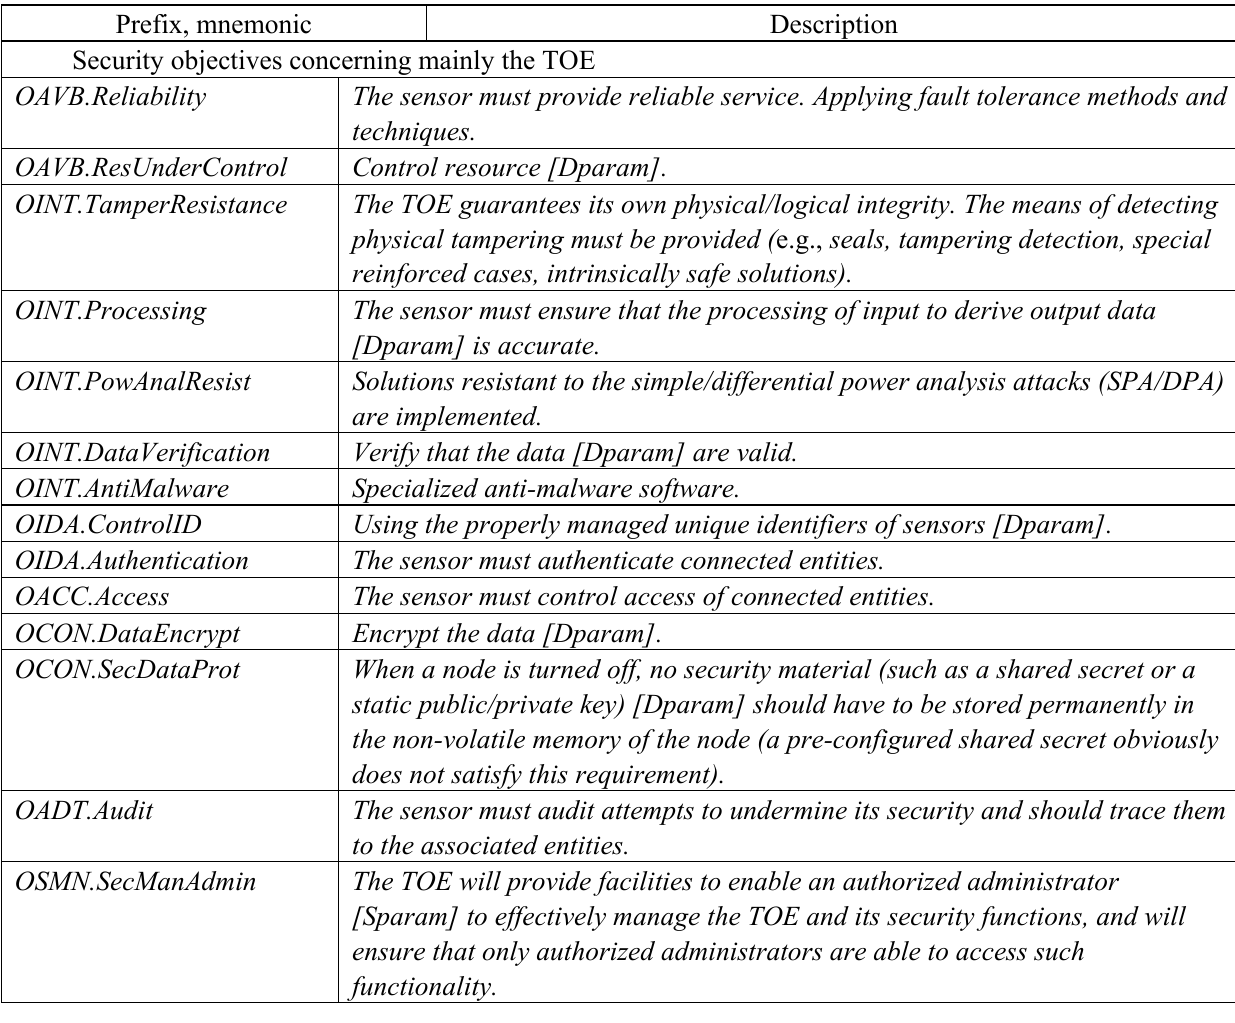
Table 15. Enhanced generics representing security